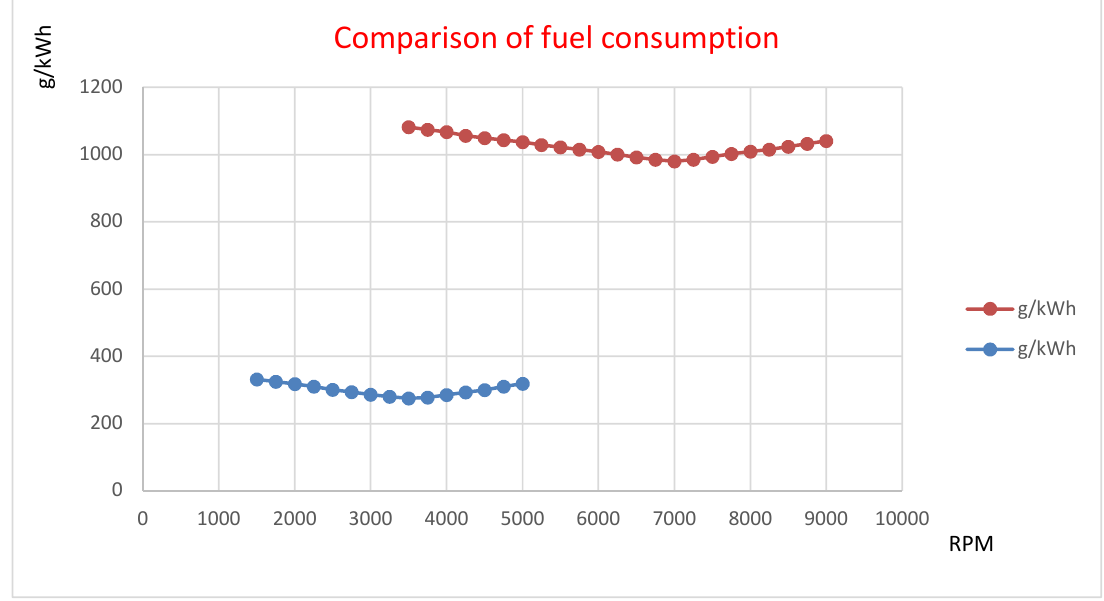
Figure 26. Comparison of consumption of engines with serial piston and piston no. 3.